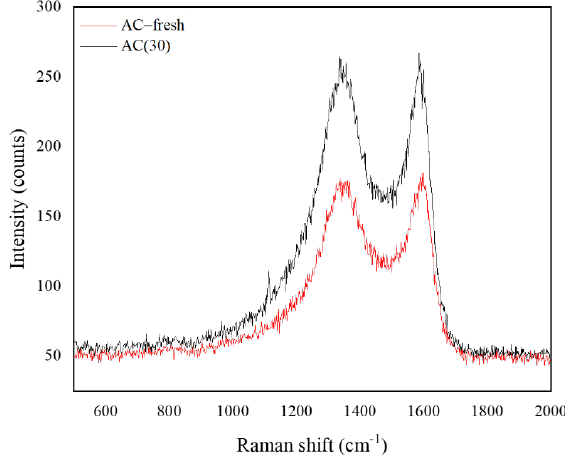
Figure 8. Raman spectra of fresh AC and functionalized AC (30).